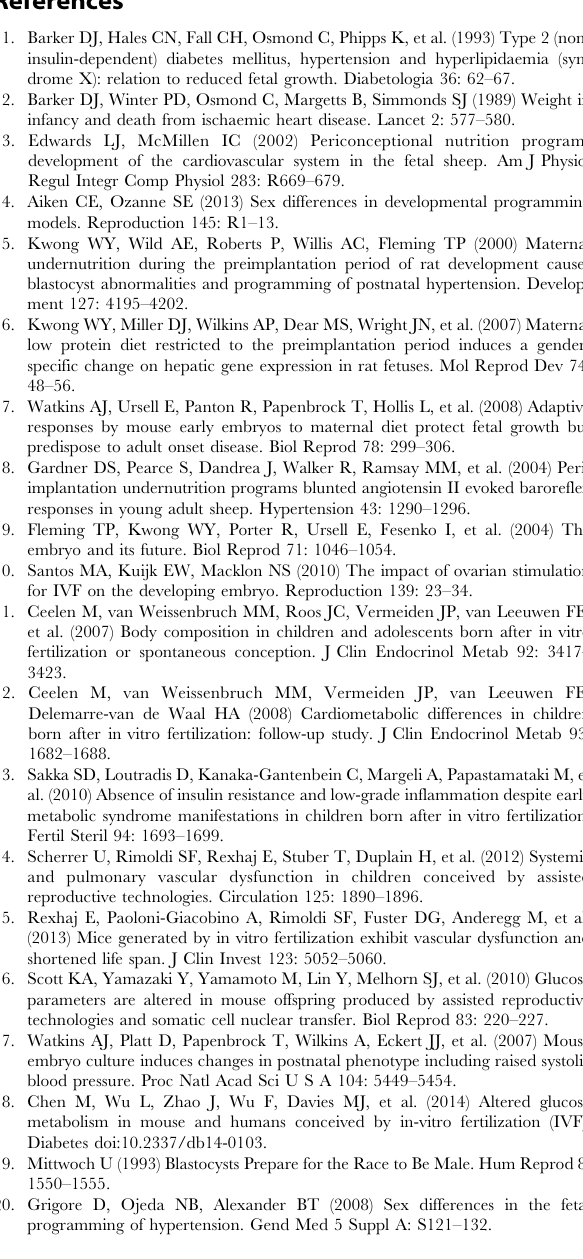
Figure S1 Tissue weight ratio (normalized to body weight) in female mice offspring. **Diet effect, P , 0.001. (A) Liver; (B), Inguinal fat, *OS vs NC, P =0.02; IVF vs NC, P =0.001; (C), Parametrial fat, *OS vs NC, P= 0.01; IVF vs NC, P , 0.001. Table S1 TaqMan primers and probes used for gene expression